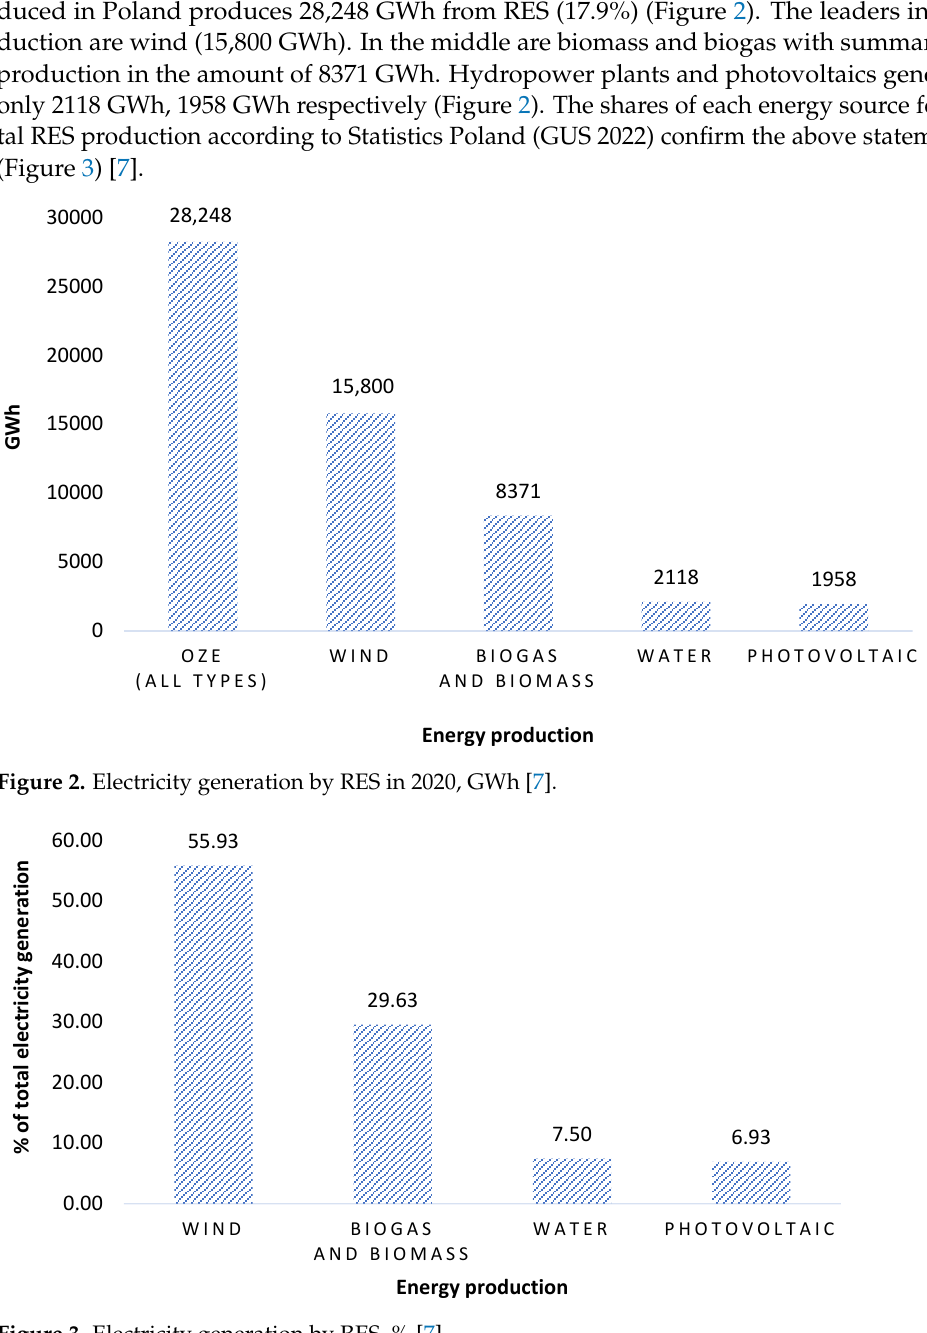
Figure 1. Structure of energy production in 2020, GWh [6].